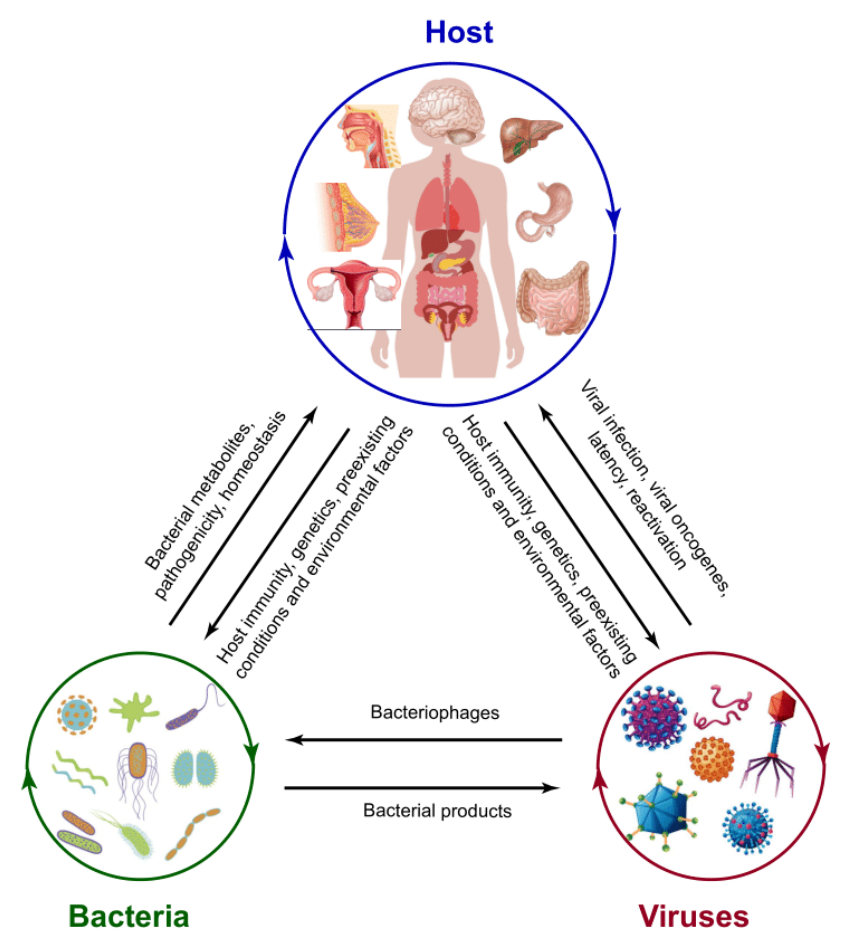
Figure 2. The interrelations of the host, bacteria, and virus. The microbiota of the host, including both bacterial and viral pathogens, could be affected by host immunological activities, genetics, pre- existing conditions, and environmental factors. Bacterial structural components and metabolites and host secretary molecules facilitate viral-bacterial interaction. As one of the viruses, bacteriophages can infect bacteria and have a critical role in shaping bacterial community structure and evolution in virulence. Reversely, bacterial products, such as LPS, could be used by the virus for replication. Fourth, viral and bacterial and pathogens may act synergistically on common patho- logical and molecular pathways to acquire hallmarks of cancer, reinforcing oncogenic signals from each other. Triggering inflammation is a major pathway exploited by both bacterial and viral pathogens. In fact, chronic inflammation is a prerequisite, premalignant stage for gastric and liver cancers. Beside the primary pathogens (HP and HCV) causing gastritis and hepatitis, proinflammatory actions from additional pathogens are likely to contribute to the progression of premalignant sequences. Furthermore, at a molecular level, viral and bacterial pathogens modulate common oncogenic signalling pathways as well as tumour suppressors within specific anatomic niches. These include Wnt/ β -catenin, NFkB, c-myc, PI3K-AKT, JNK, ERK, P53, ATM, and caveolin-1. Some of these effects may be mediated through alterations in host epigenetic properties, including DNA methylation and micro-RNAs, as discussed above. Collaborative actions on the common key signalling pathways by two different entities may be advantageous to surpass threshold, if any, to acquire of specific cancer